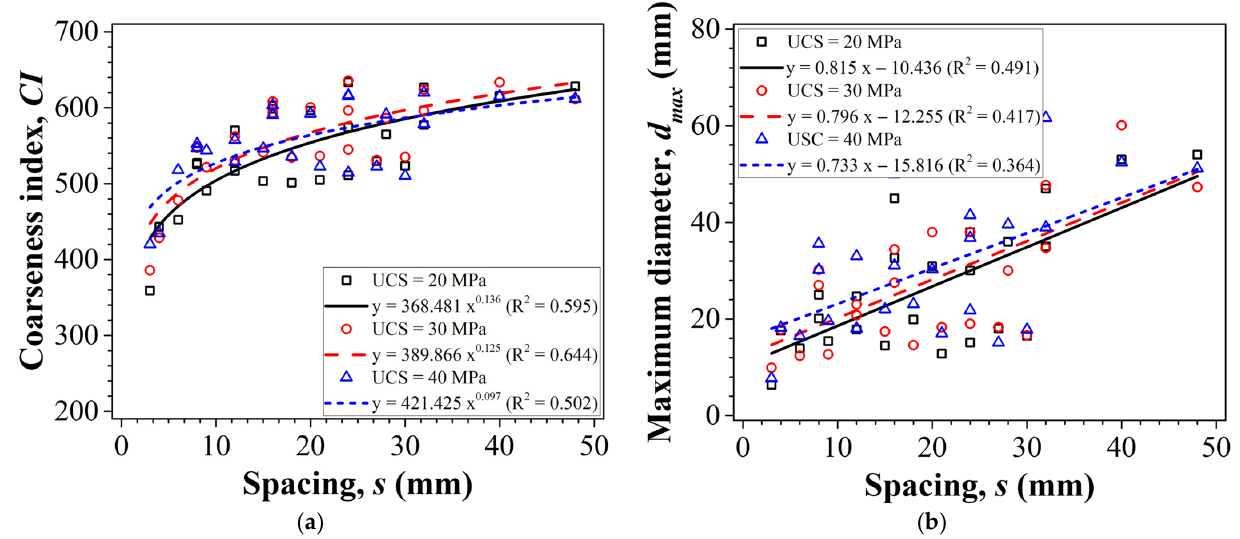
Figure 8. Relationship between spacing and ( a ) CI ; ( b ) maximum diameter.